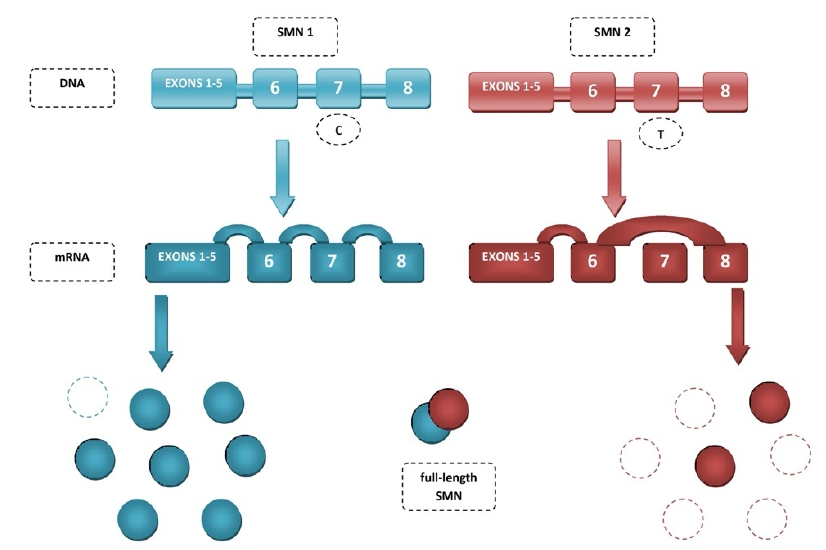
Figure 1. Splicing of SMN genes.